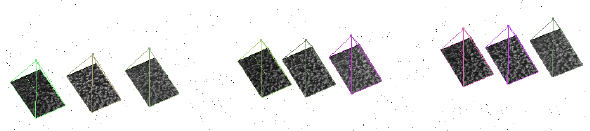
Figure 4. Example of three sequential spectral camera data cubes with three bands each. Time difference between the channels are 0s, 1.125s and 1.6s.